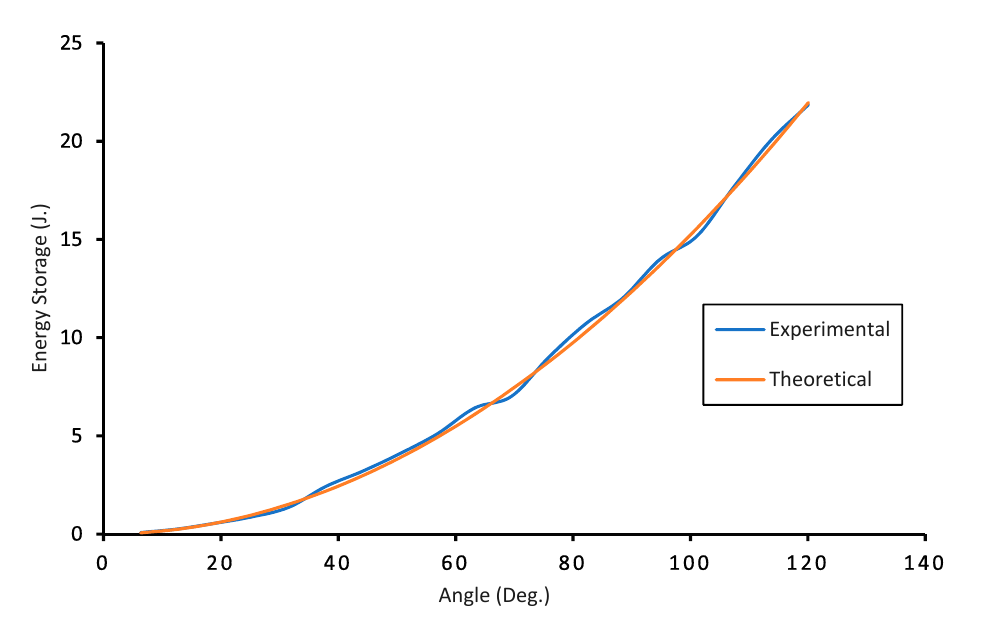
Figure 18. Characteristic of spiral spring stiffness the average experimental values and theoretical curves.